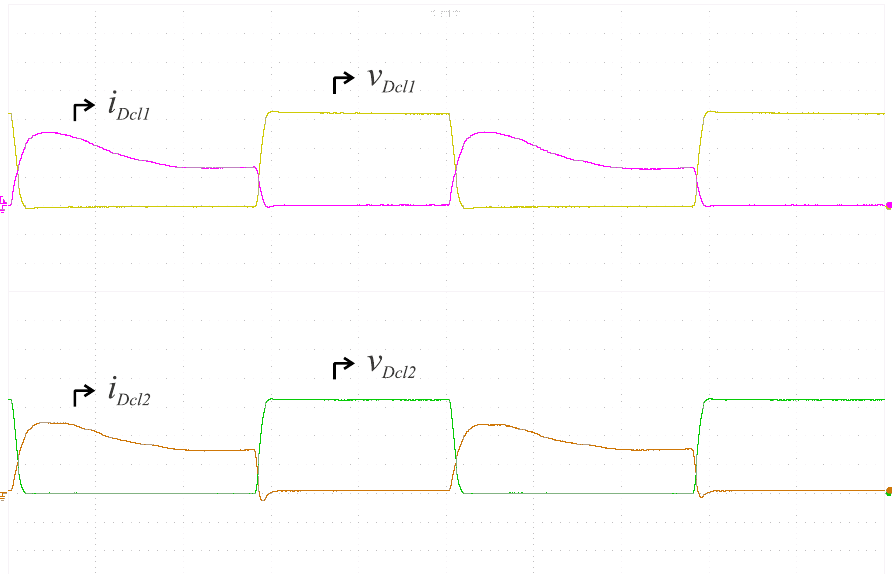
Figure 9. Top: diode D cl 1 voltage v Dcl 1 (20 V/div) and current i Dcl 1 (500 mA/div); bottom: diode D cl 2 voltage v Dcl 2 (20 V/div) and current i Dcl 2 (500